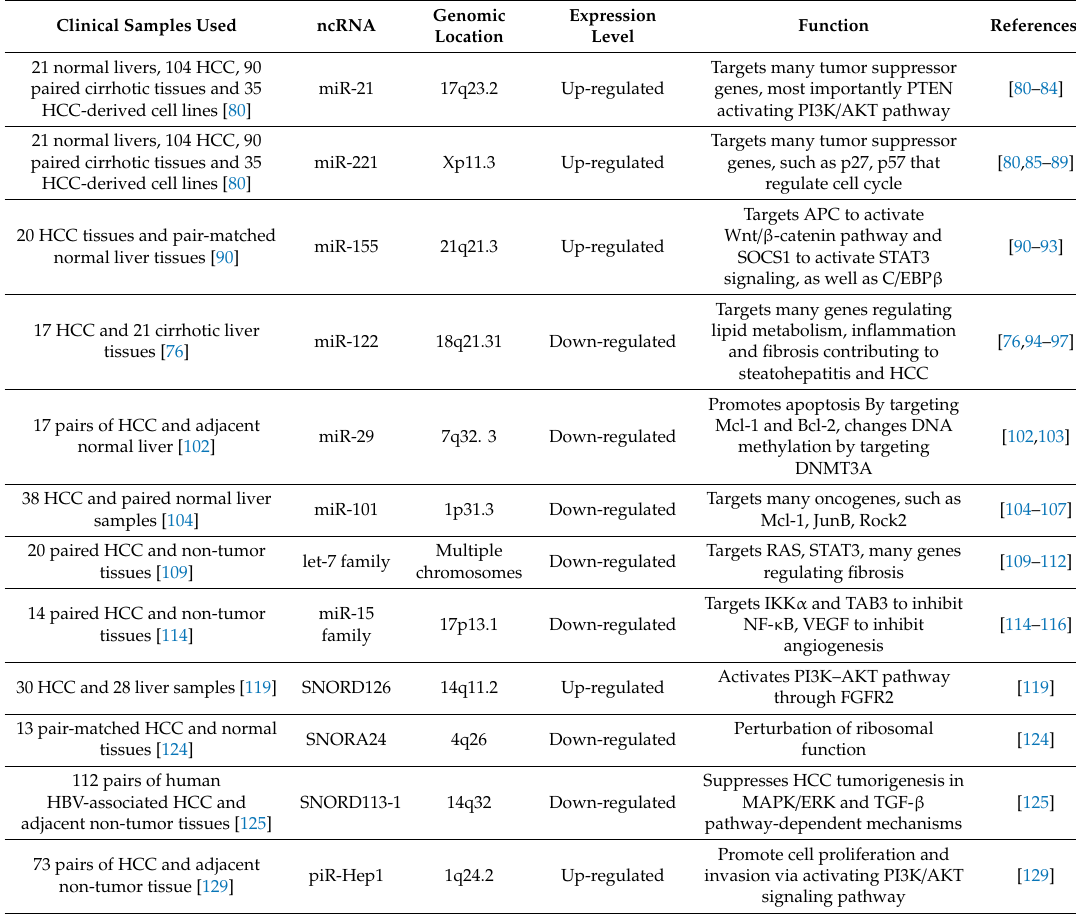
Table 2. Examples of deregulated expression of small ncRNAs in